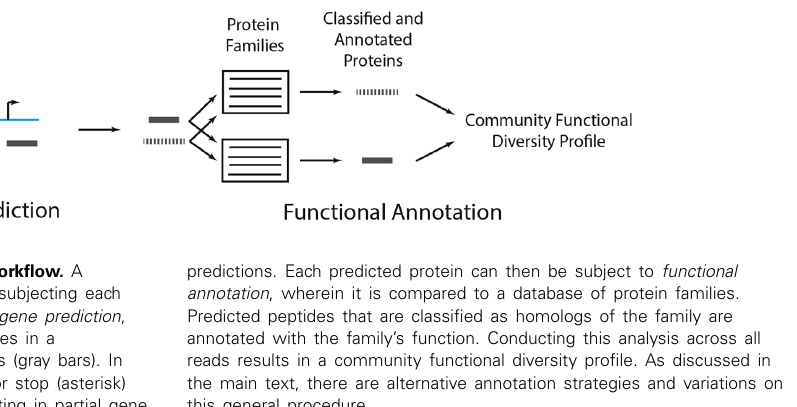
FIGURE 3 |A metagenomic functional annotation workflow. A metagenome (colored lines, left) can be annotated by subjecting each reads to gene prediction and functional annotation. In gene prediction , various algorithms can be used to identify subsequences in a metagenomic read (blue line) that may encode proteins (gray bars). In some situations, coding sequences may start (arrow) or stop (asterisk) upstream or downstream the length of the read, resulting in partial gene